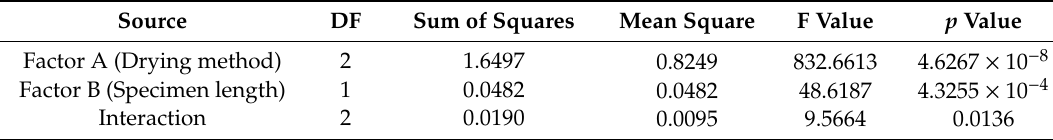
Table 3. Two-way analysis of variance with drying rate.